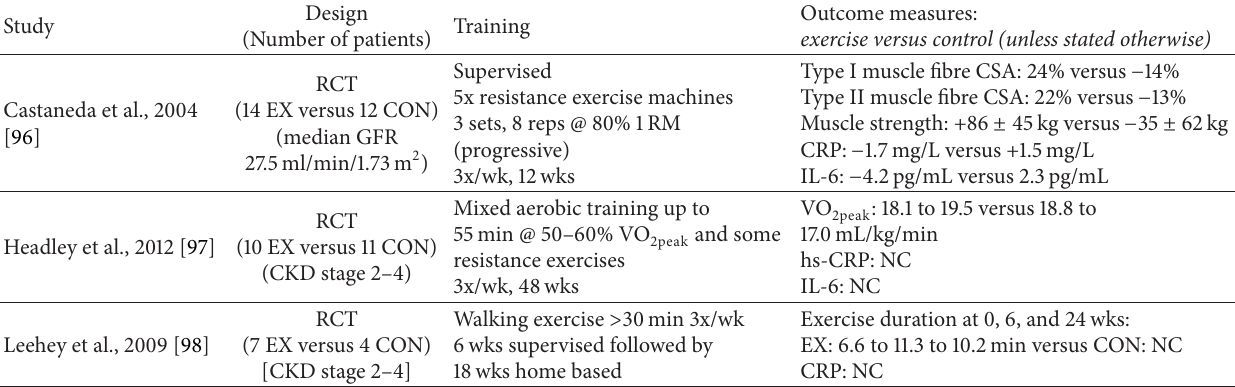
Table 4: Exercise intervention studies in predialysis chronic kidney disease